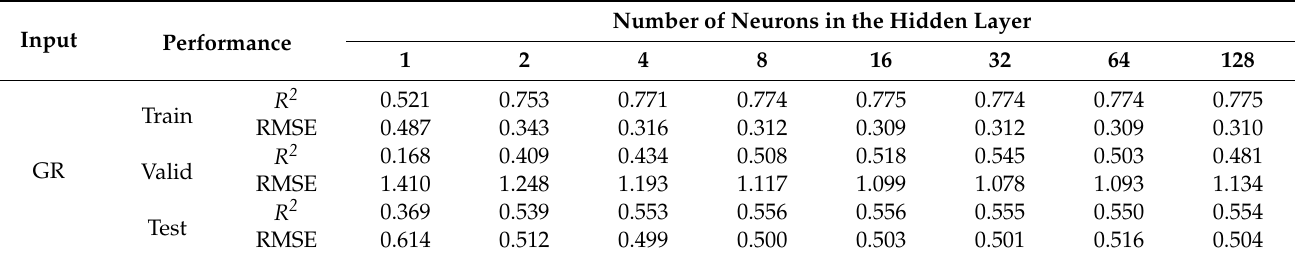
Table A1. Performance for generating synthetic Vp using a single input